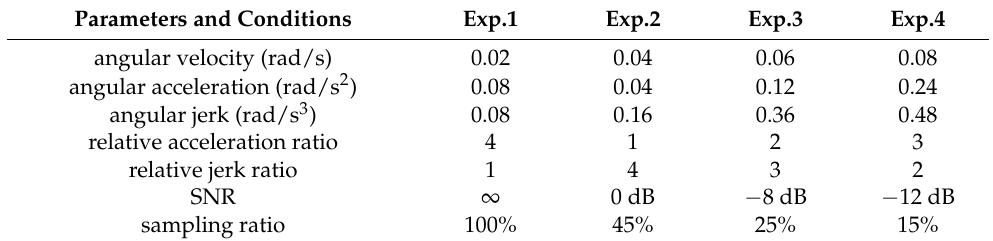
Table 4. The motion parameters and imaging conditions of the four experiments.